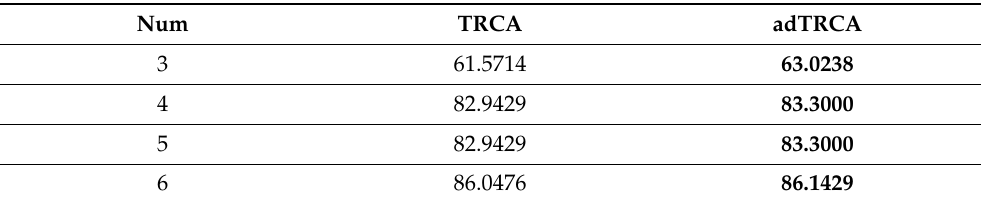
Table 6. Classification accuracy (%) on Speller dataset with respect to the number of training trials— 9 channels.